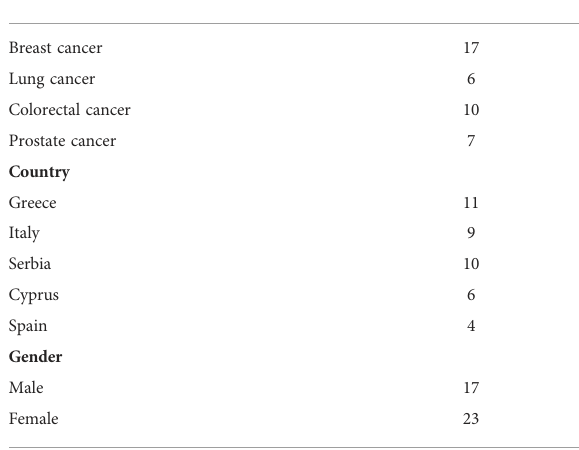
TABLE 1 Characteristics of study participants (cancer